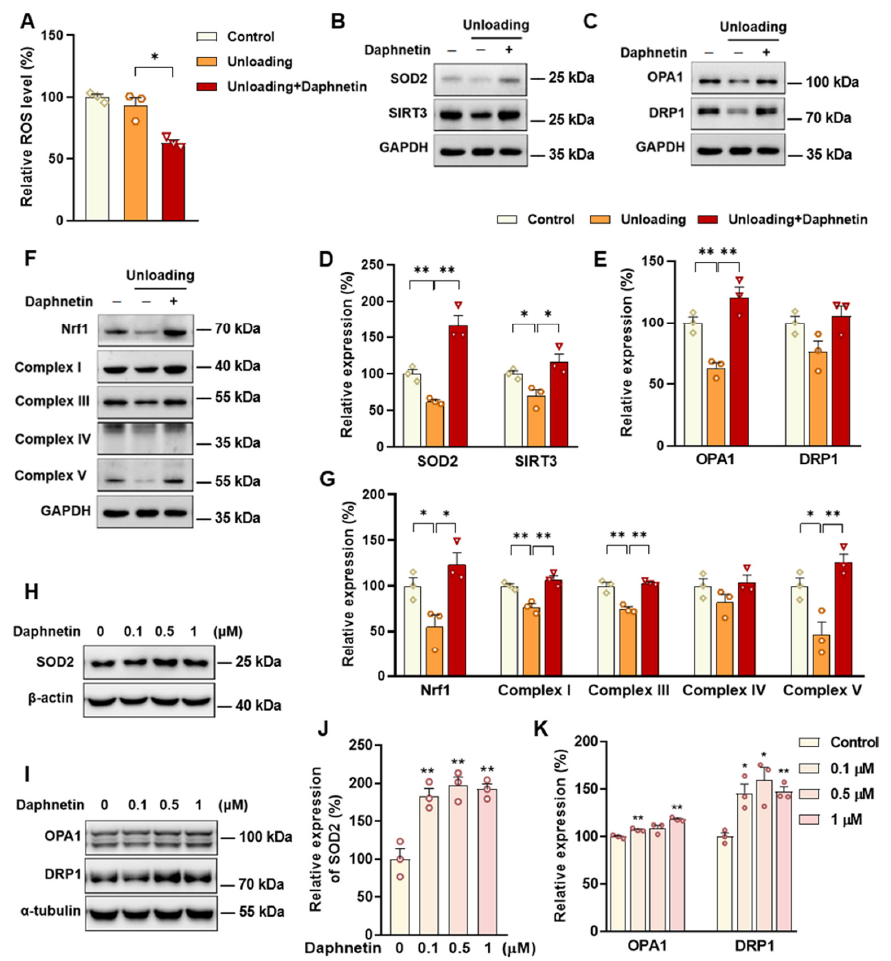
Figure 7. The effects of daphnetin on SIRT3/SOD2 pathway and mitochondrial homeostasis in osteoclastogenesis. Primary osteoblasts were isolated from mice and induced to differentiate for 2 days, ( A ) Intracellular ROS level in bone marrow monocyte-derived osteoclasts was determined with DCF probe. Expression of SOD2, SIRT3, mitochondrial dynamic- and biogenesis-related proteins were also determined by Western blot (( B , C , F ) Western blot images; ( D , E , G ) statistical analysis). RAW264.7 cells treated with indicated concentrations of daphnetin were induced to differentiate in vitro. After differentiation for 3 days followed by daphnetin treatment for 6 h, expression of SOD2, OPA1 and DRP1 were determined by Western blot (( H , I ) Western blot images; ( J , K ) statistical analysis). Data are mean ± S.E.M. ( n = 3); * p < 0.05, ** p < 0.01 between the connected groups or versus